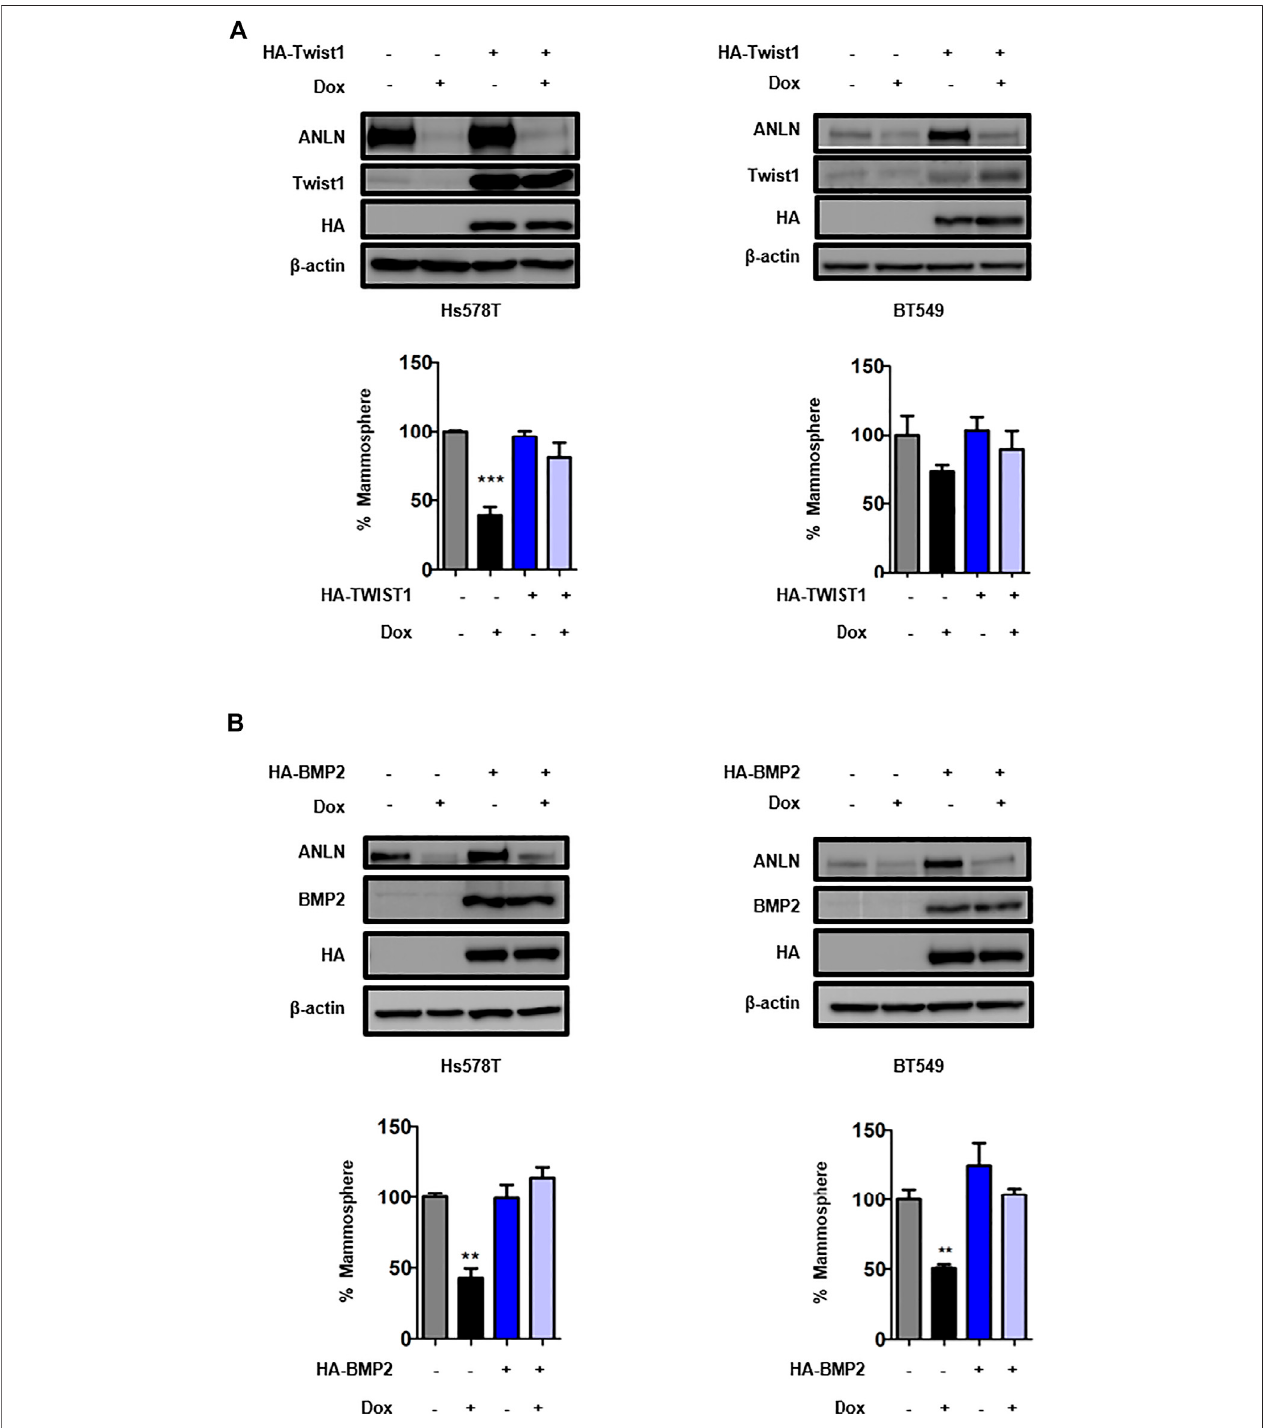
FIGURE4| TWIST1and BMP2arecriticaldownstream effectorsofANLN inregulatingTNBC CSCs. (A) Hs578t andBT549cells expressing HA-Twist1orcontrol vector were infected with tet-on ANLN gRNA1. Cells were treated with dox (100 ng/ml) for 7 days, and then subjected to mammosphere formation assay. Error bars, mean ± SEM of 3 independent experiments. Whole cell lysates were subjected to Immunoblotting analysis. ***, p < 0.001. (B) Hs578t and BT549 cells expressing HA- Bmp2orcontrolvectorwereinfectedwithtet-onANLNgRNA1.Cellsweretreatedwithdox(100 ng/ml)for7 days,andthensubjectedtomammosphereformation assay. Error bars, mean ± SEM of 3 independent experiments. Whole cell lysates were subjected to Immunoblotting analysis. **, p < 0.01.